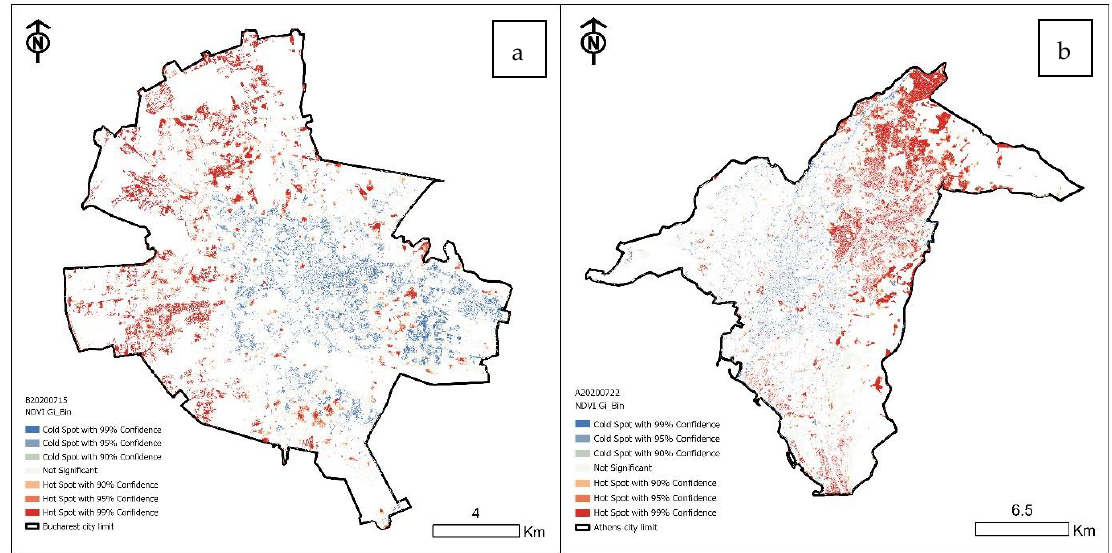
Figure 6. Optimized hot spot distribution of NDVI for July 2020 in Bucharest ( a ) and Athens ( b ). Testing the spatial distribution of the quality of small urban green areas highlighted similar tendencies for the NDVI and MSAVI2 in both cities. The ANOVA tests revealed